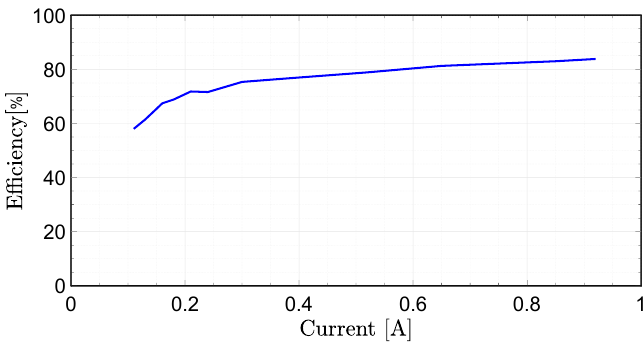
Figure 15. The efficiency of the forward-buck combination.